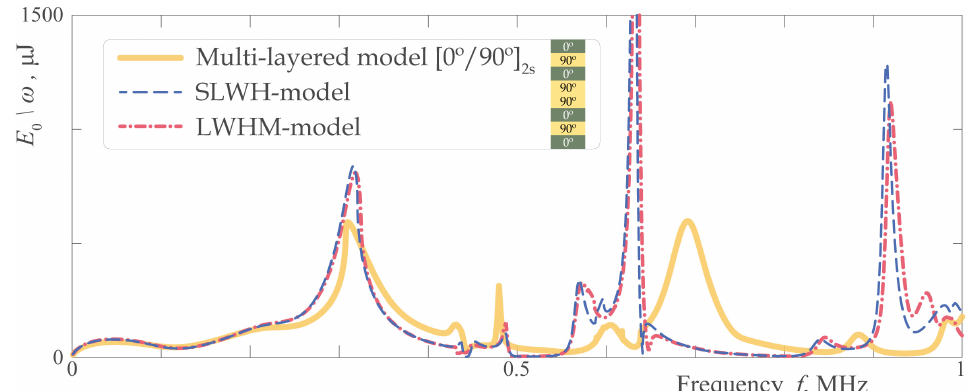
Figure 11. The wave energy transferred into the waveguide E 0 ( f ) by the PWT on the surface of multi- layered waveguide [ 0 ◦ ,90 ◦ ] 2s (thick solid line), and waveguides with effective properties estimated according to the SLWH-model (thin solid line) and the LWHM-model (dash-dotted line).